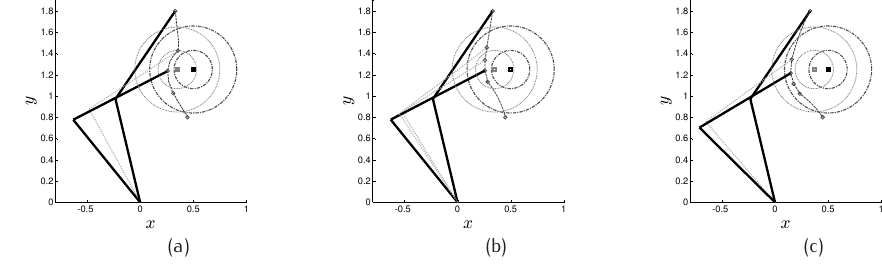
Figure 9. Comparison of (a) APF, (b) modified search, and (c) our proposed algorithm in dealing with dynamic obstacles.